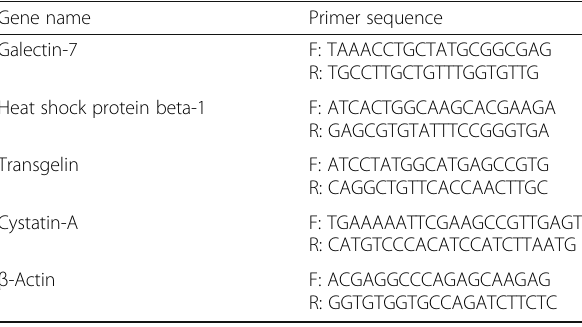
Table 1 Sequence of primers, which were used for Real-Time